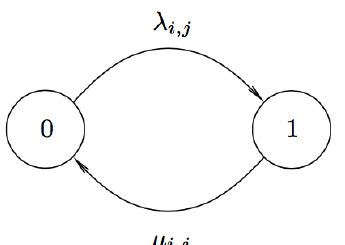
Figure 4. Continuous-time Markov chain for the connected-disconnected transition between p i and h j . Let 1/0 represent the state in which p i and h j are connect/disconnected. The transition rates from zero to one and from one to zero are given by λ i , j and µ i , j ,